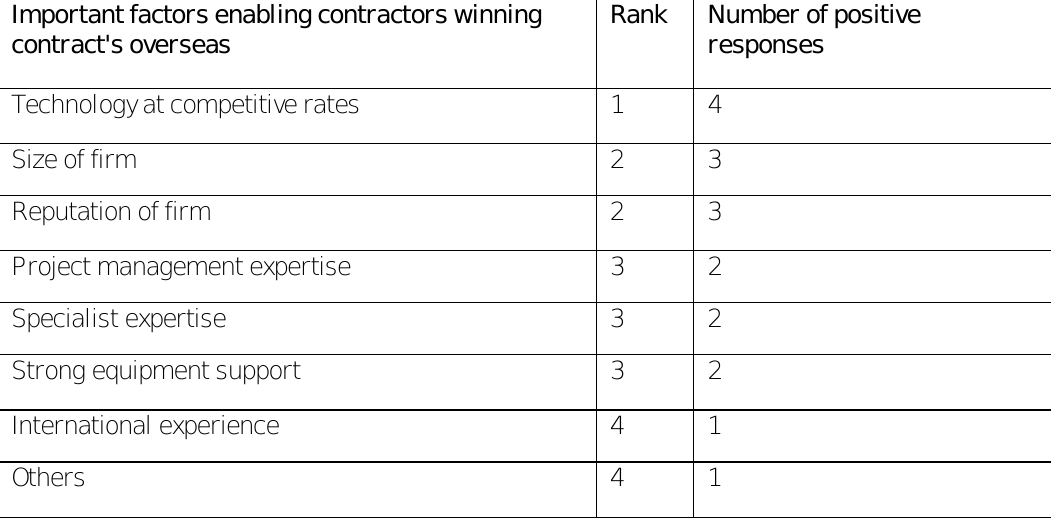
Figure 2: Assistance needed to enable contractors to export